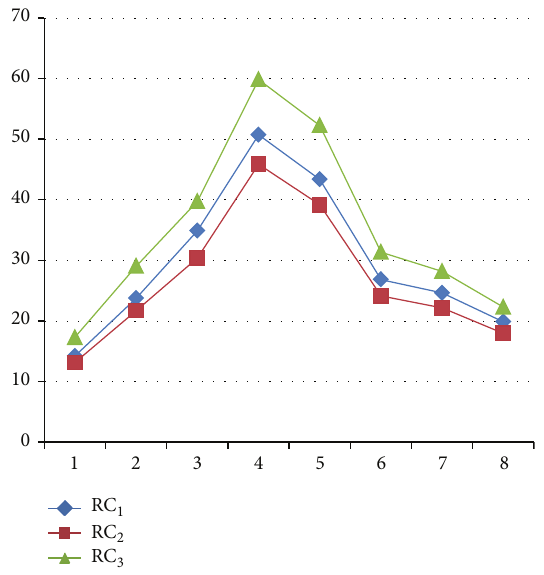
Figure 4: Actual loss of risk consequence.